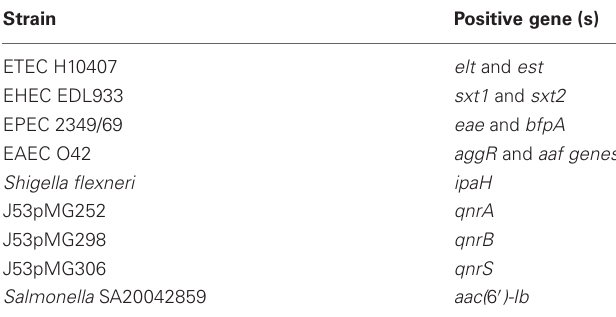
Table 3 | PCR control strains used in this